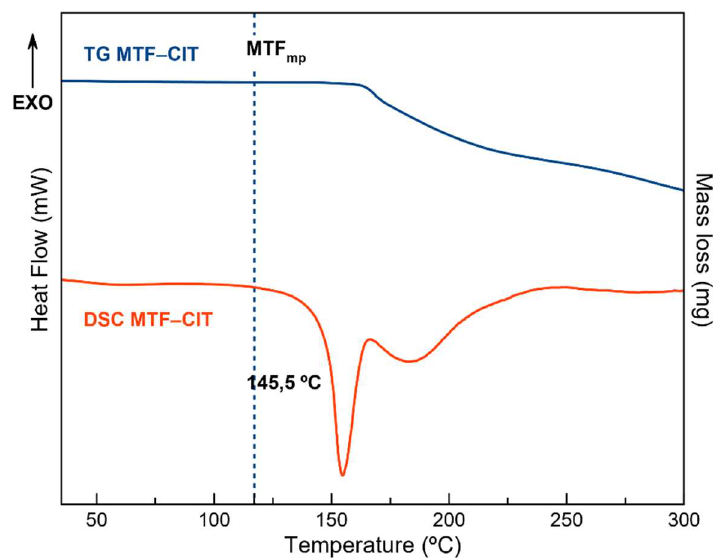
Figure 8. DSC measurement of MTF–CIT showing its melting point compared with MTF (vertical dotted line) melting point followed of a decomposition event.